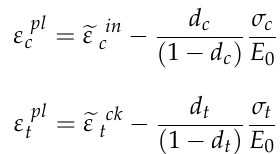
Figure 4. The CDP model. ( a ) Compression constitutive; ( b ) tensile constitutive. The softening stage in the stress–strain curve of concrete is defined by setting the in- elastic strain (cid:101) ε in under compression and the strain ε ck under tensile cracking. In ABAQUS, c t the inelastic strain (cid:101) ε in under compression and the strain ε ck under tensile crack are trans- c t formed into an equivalent plastic compressive strain ε pl c and an equivalent plastic tensile strain ε pl using Formulas (7) and t